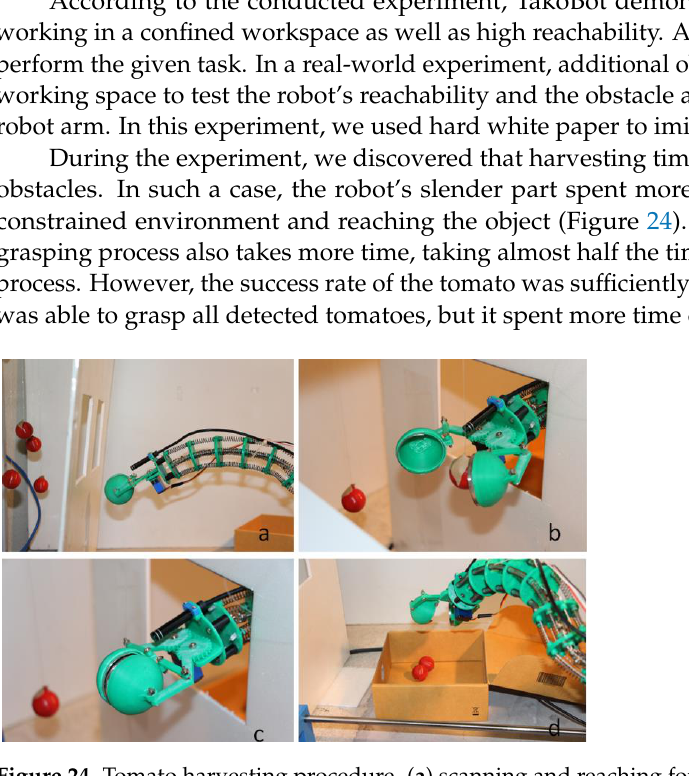
Figure 23. TakoBot object reaching angles.